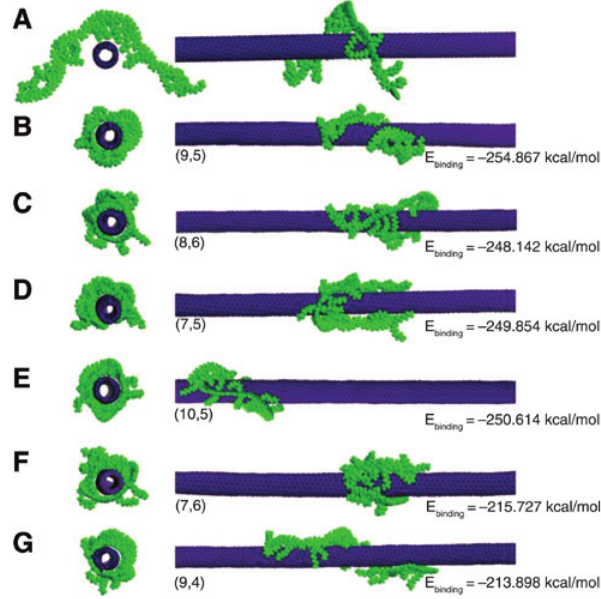
Figure 5: The cross-sectional and the horizontal views of the wrapping configurations of PFT on SWCNTs with different